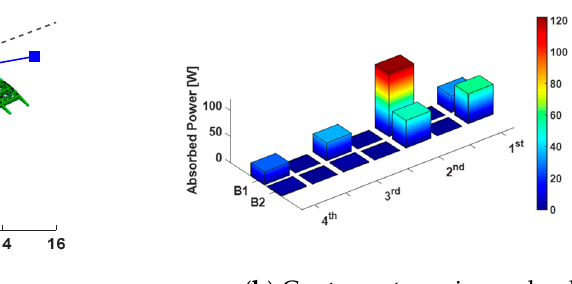
Figure 21. Deviation from the baseline configuration at rest: static load of 1520 N.